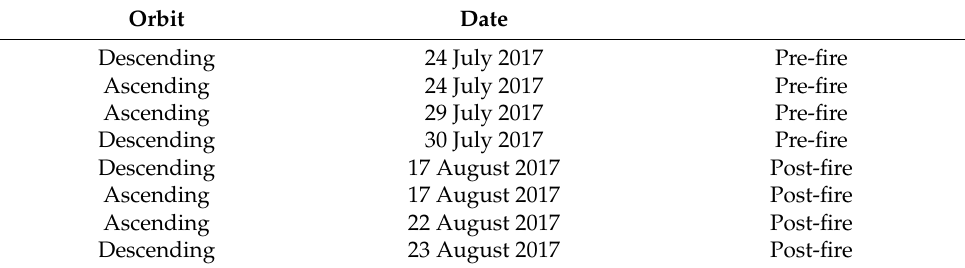
Table 1. Multitemporal Sentinel-1 SAR images of the study